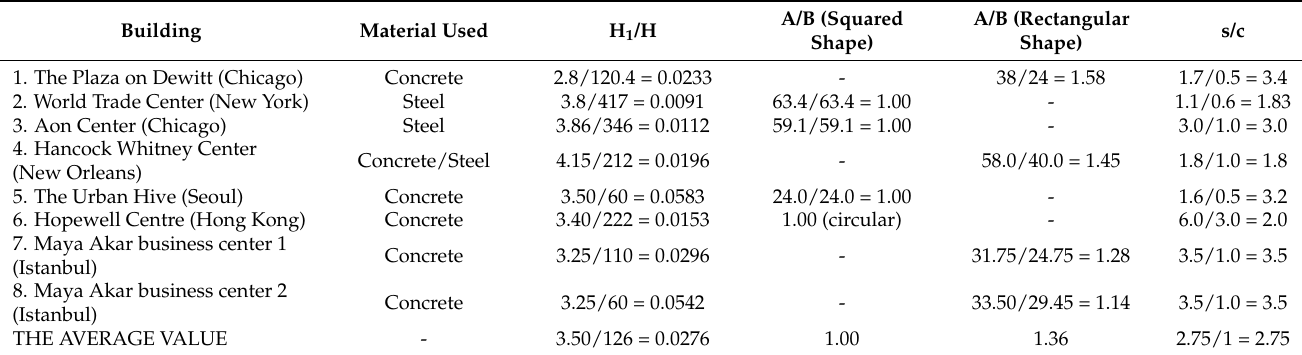
Table 1. Structural parameters of some well-known tall buildings with tube structural